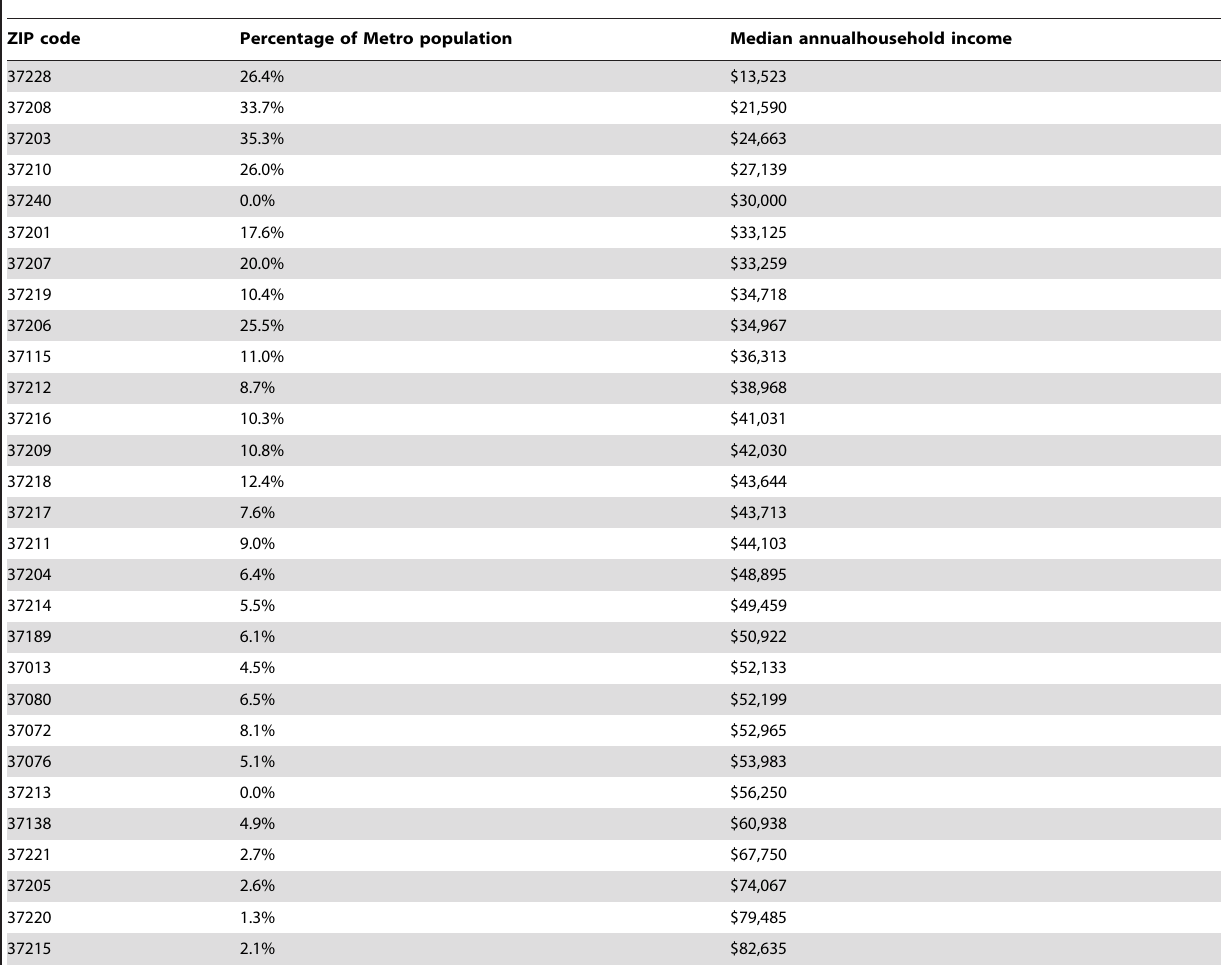
Table 6. Geographical grouping (by ZIP code) of households within Davidson County according to median household income.